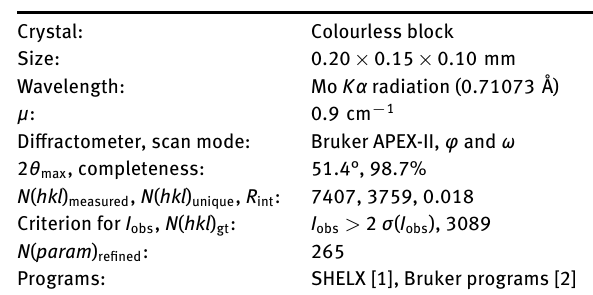
Table 1: Data collection and handling.